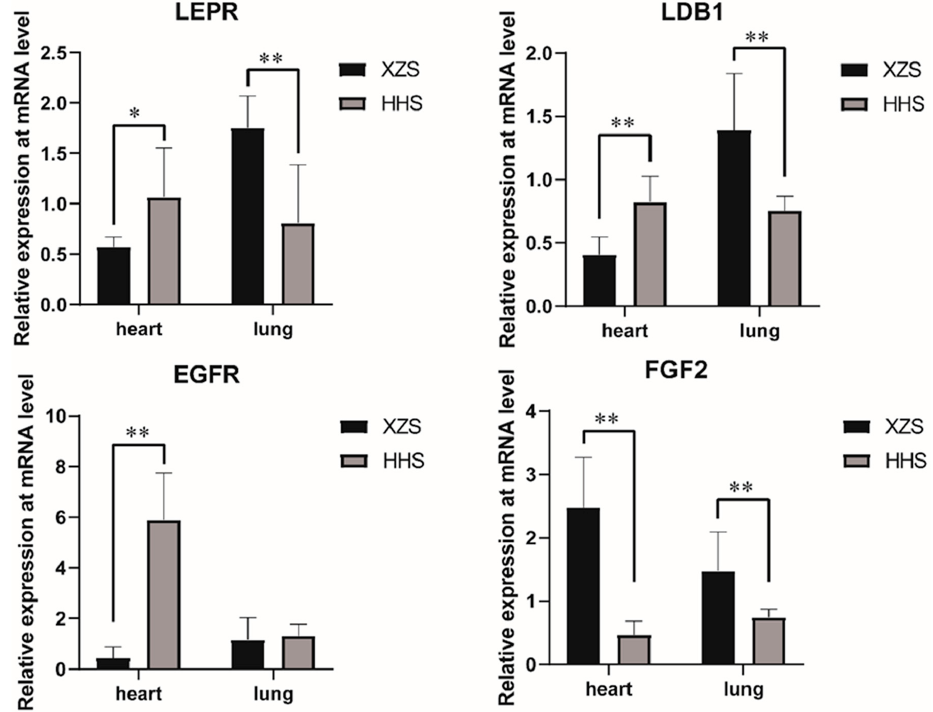
Figure 4. Expression levels of LEPR , LDB1 , EGFR and EGF2 in heart and lung tissues. * represents significant difference ( p < 0.05) and ** represents extremely significant difference ( p < 0.01).